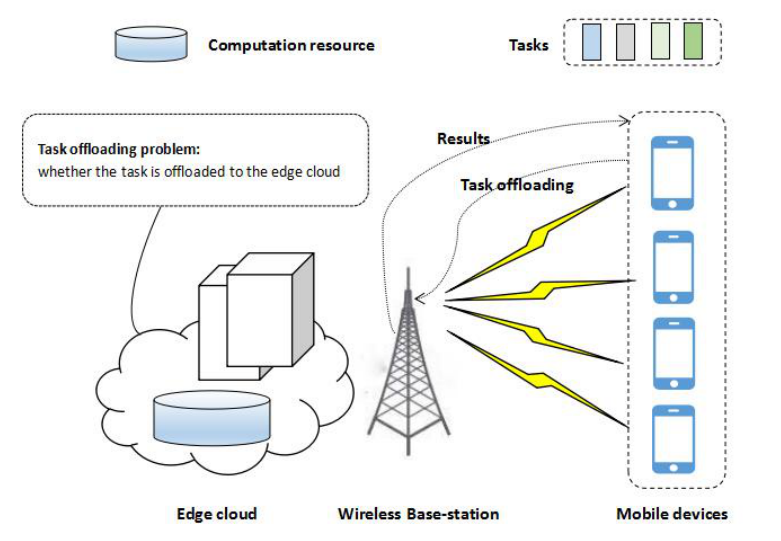
Figure 1. A multi-user system for